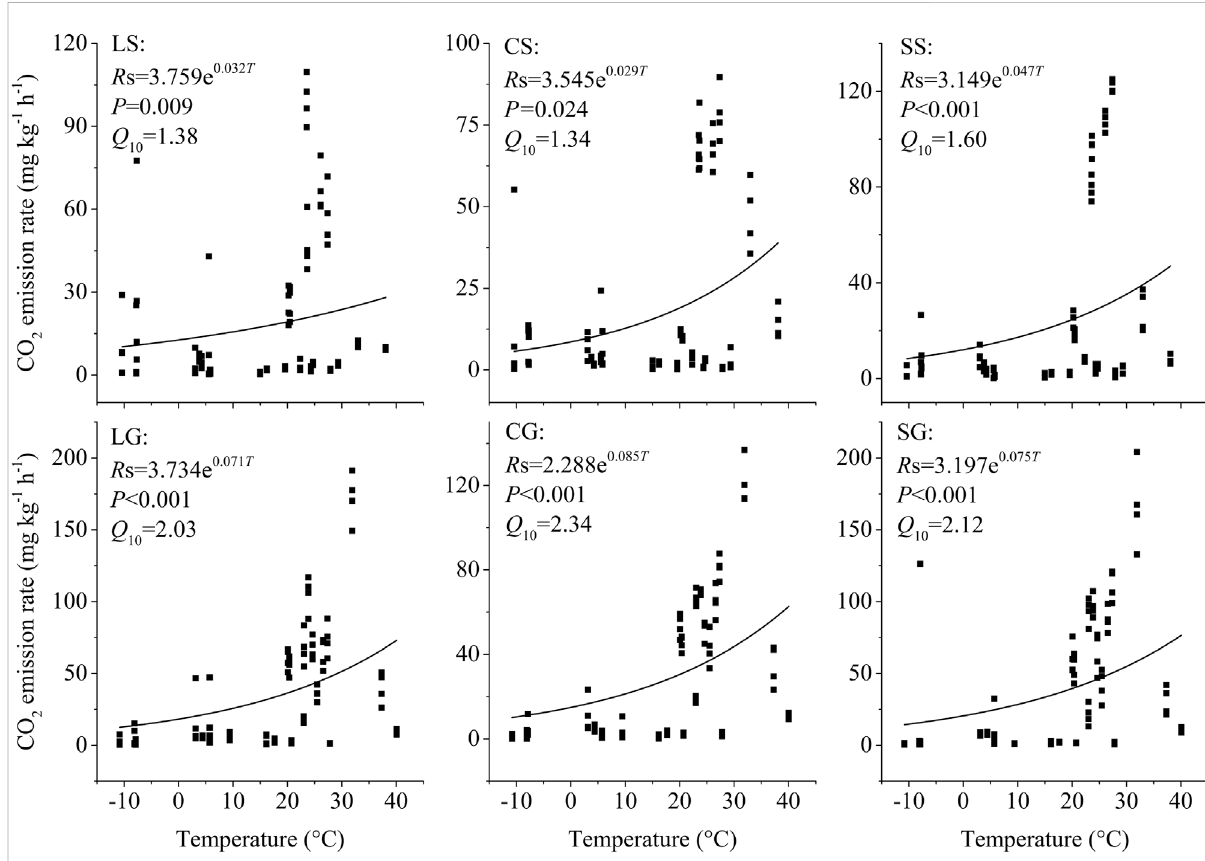
FIGURE 2 Temperaturesensitivity( Q 10 )ofCO 2 emissoinsfromstandinglitterandlitterontheground.LS,CS,andSSrepresentstandinglitterofleaf,culm, and sheath. LG, CG, and SG represent leaf, culm, and sheath litter on the ground. R s represents the CO 2 emission rate. T represents the air